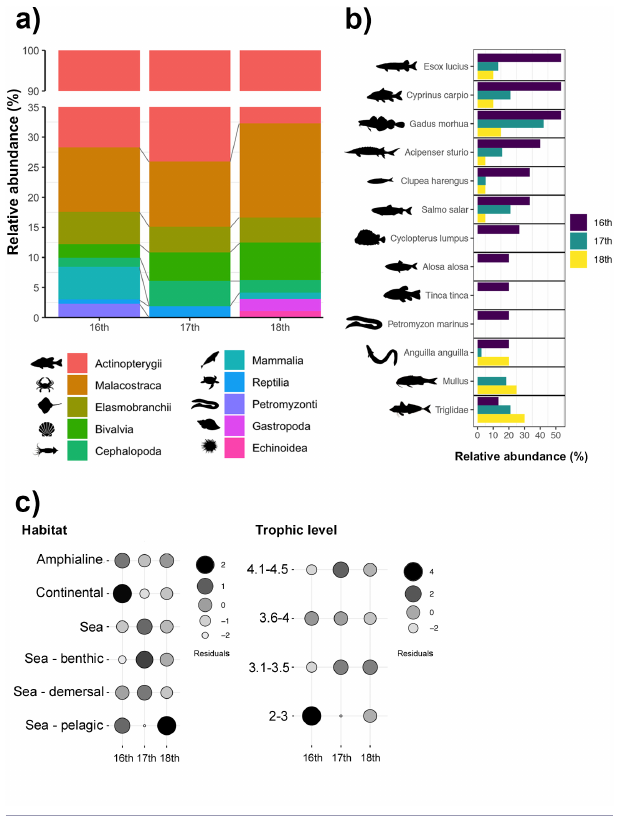
Fig. 4 . Representation in paintings of taxa by period. (a) Relative abundance (in %) of class of taxa in the paintings according to the three periods: 16th, 17th, and 18th centuries. (b) Abundance (in %) of taxa in the paintings according to the three periods: 16th, 17th, and 18th centuries. Only the species with the highest variations are shown (based on the first decile of the distribution of standard deviation between the three periods). (c) Residual values of chi squared tests performed according to Habitat Group (p-value = 0.002) and Trophic Level (p-value = 9.427 x 10-7). Only the residuals of significant tests are